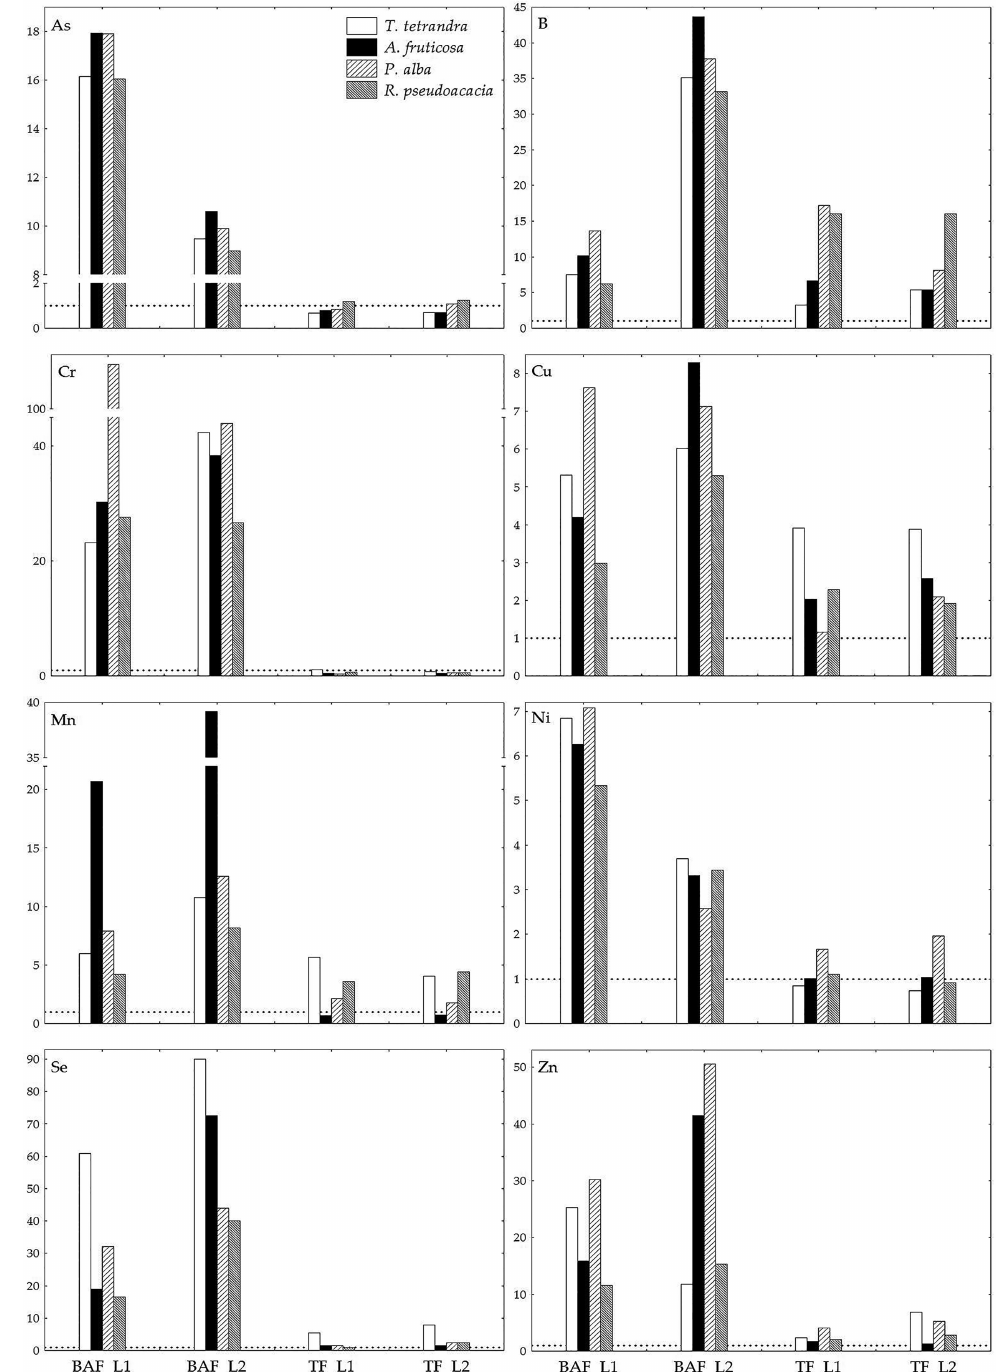
Figure 3. The Bioaccumulation (BAF) and translocation factor (TF) of trace elements in four woody plant species growing at the examined sites (L1 and